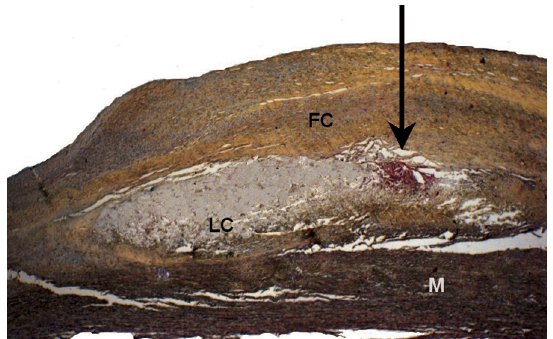
Figure 2. Cross section depicting an advanced lesion type Va. Movats staining, magnification 20 6 . LC: Characteristic lipid core. FC: Thick fibrous cap with yellow staining of collagen fibers and red-colored smooth muscle cells. M: Media. Arrow: Microhemorrhages, typically found at the lateral margin of the lipid core (red: stained fibrin).